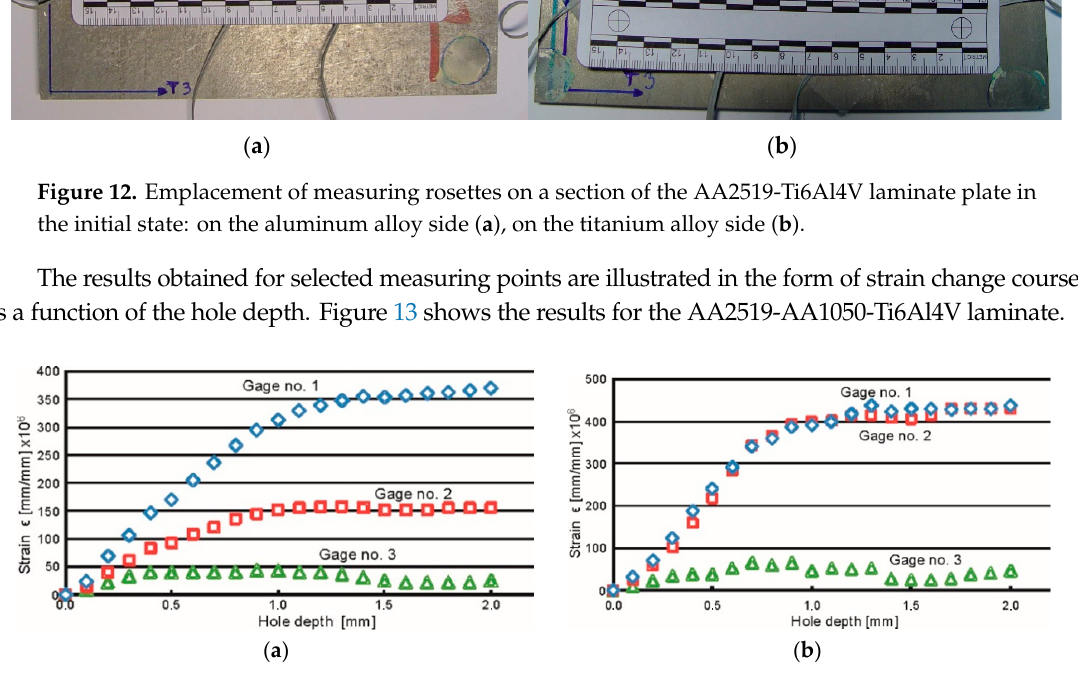
Figure 13. Graphs of strain changes depending on the hole depth on the AA2519 side ( a ) and on the Ti6Al4V alloy side ( b ) of the AA2519-AA1050-Ti6Al4V